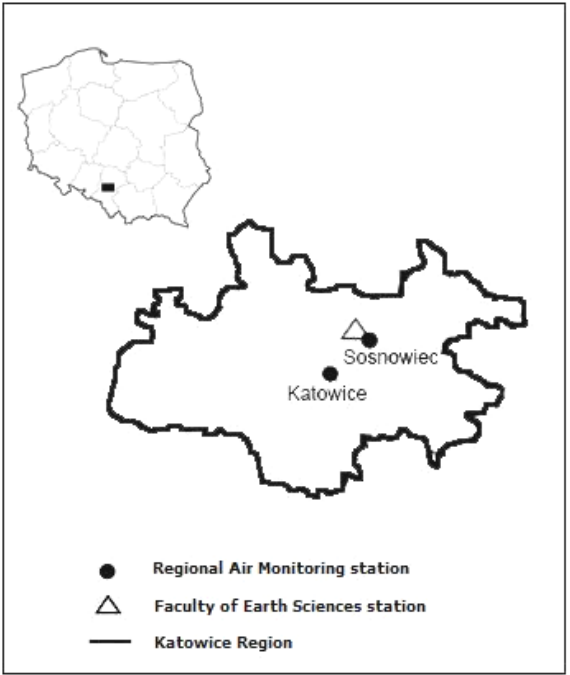
Fig.1. Localisation of regional air monitoring station in Katowice and meteorological station in